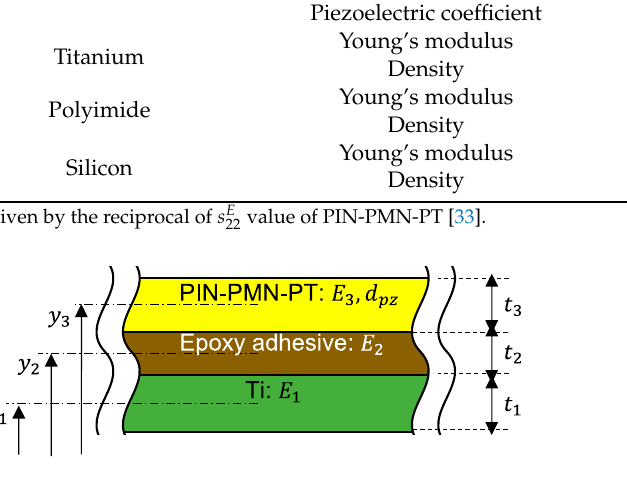
Figure A2. Layer configuration of piezoelectric actuator. Figure A1. Layer configuration of piezoelectric